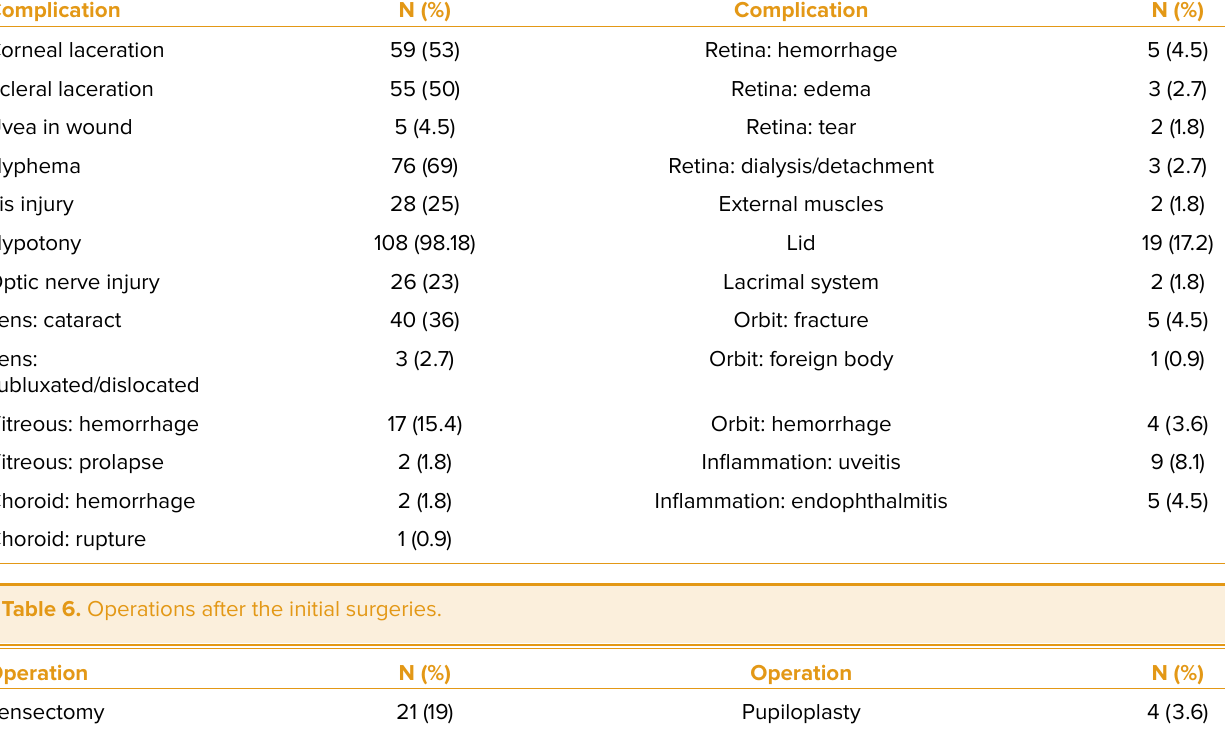
Table 5. Complications and eye layers involvement.